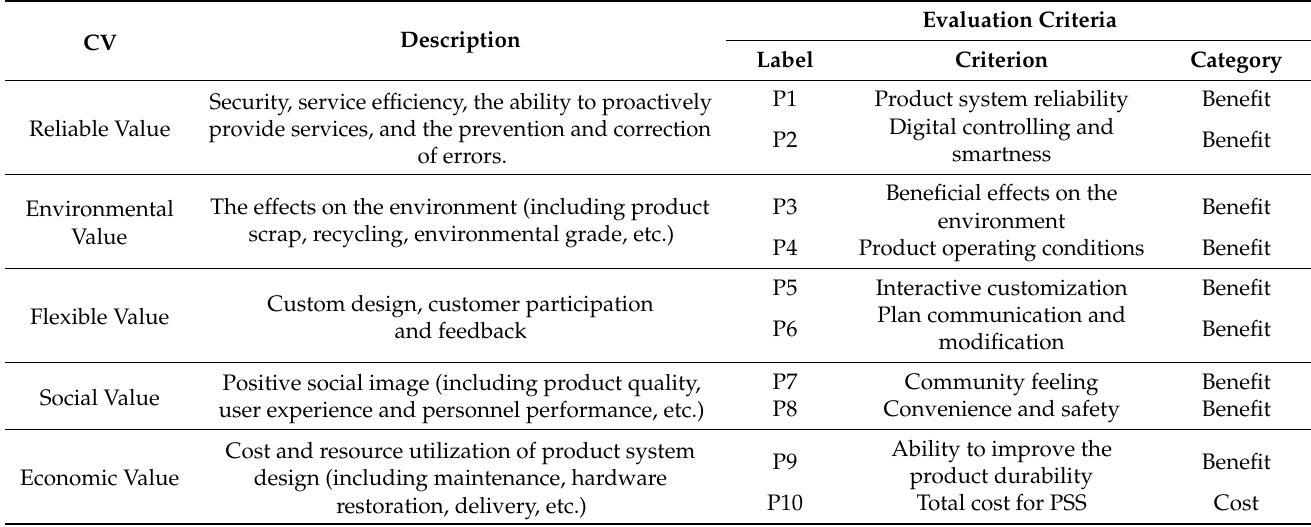
Table 3. Description of the PSS evaluation criteria for CV (Modified from Song et al. [12]). Description